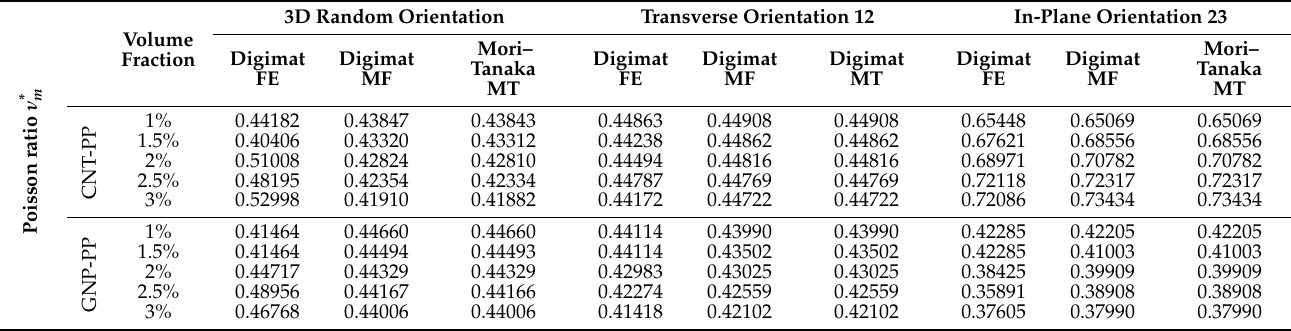
Table 3. Poisson’s ratio ν ∗ m of CNT- and GNP-reinforced PP